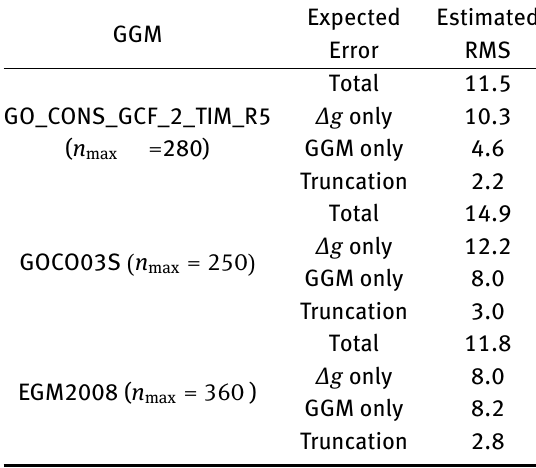
Table 4: Global RMS values for the Unbiased LSM Estimator for 3